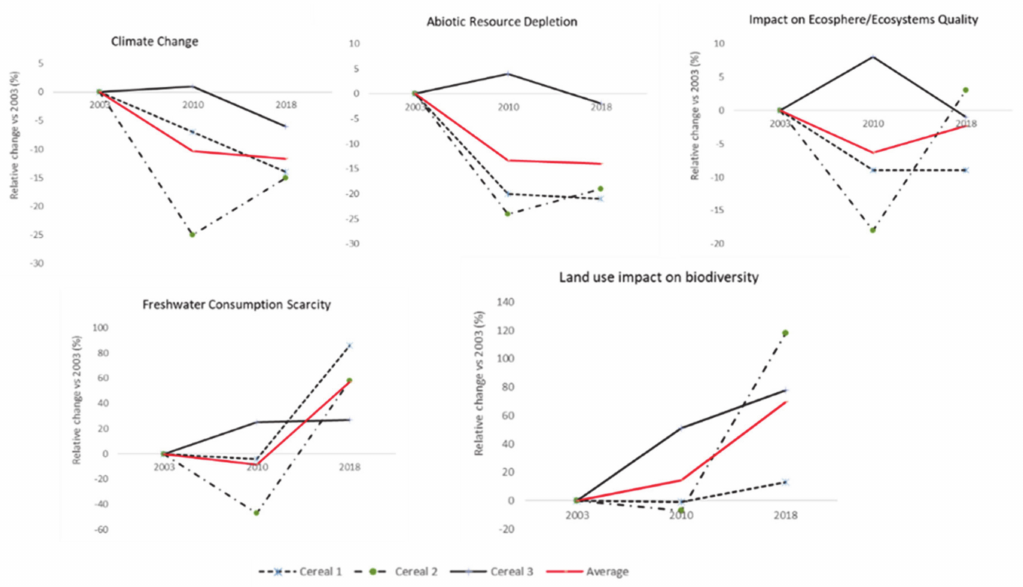
Figure 4. Changes in environmental indicators of the products studied over the 2003–2018